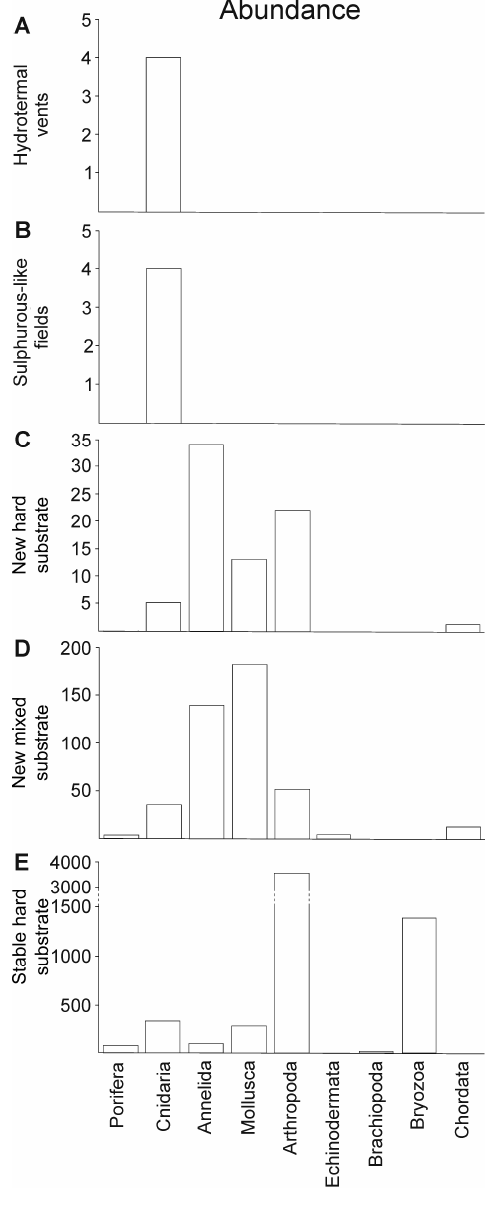
Figure 7. Abundance (number of individuals) in the different phyla collected in the benthic dredges, within the different habitats at the Tagoro volcano complex ( A–D ) and at an undisturbed area ( E ).